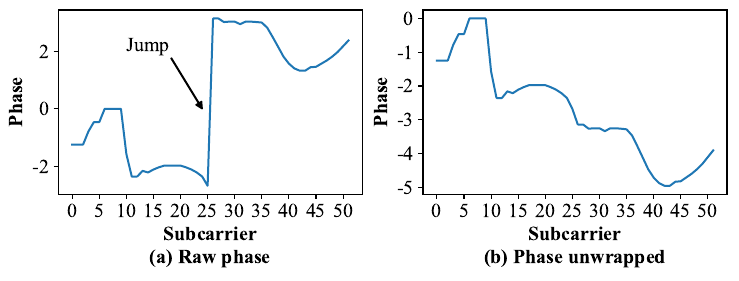
Figure 3. Phase unwrapping.